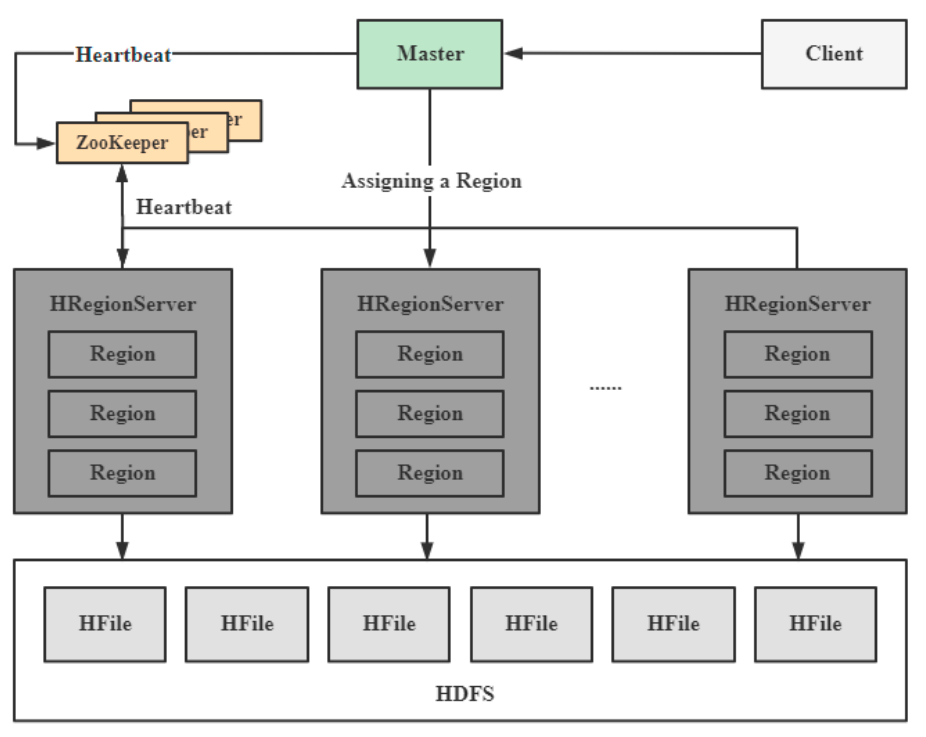
Figure 1. The structure of HBase.